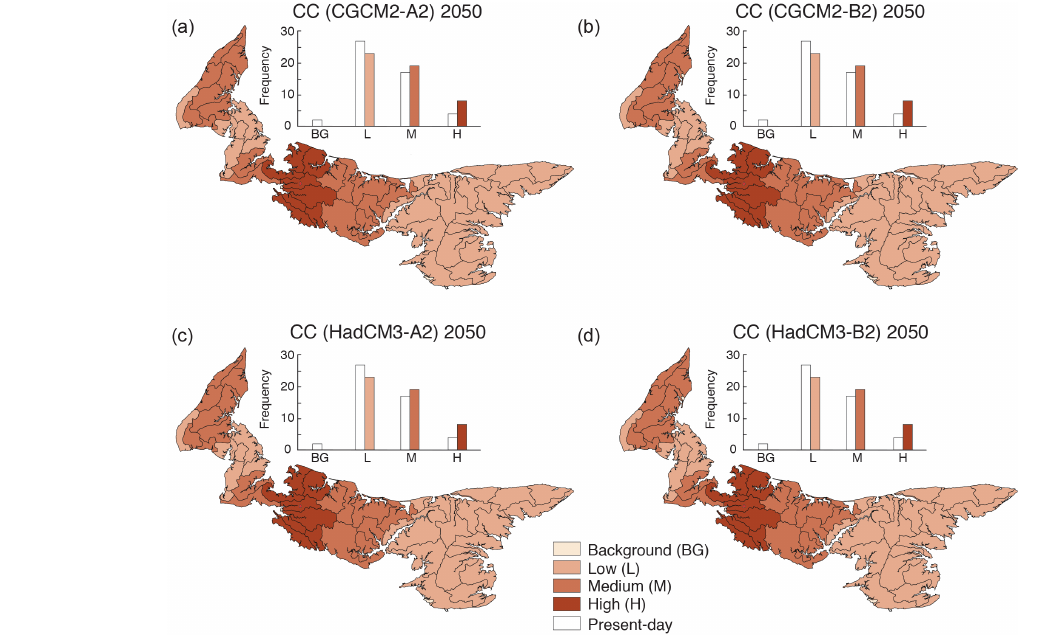
Figure 7. Class distribution of simulated mean nitrate concentration per watershed and histogram of the number of watersheds in each class for the four climate change (CC) scenarios ( a , b , c and d